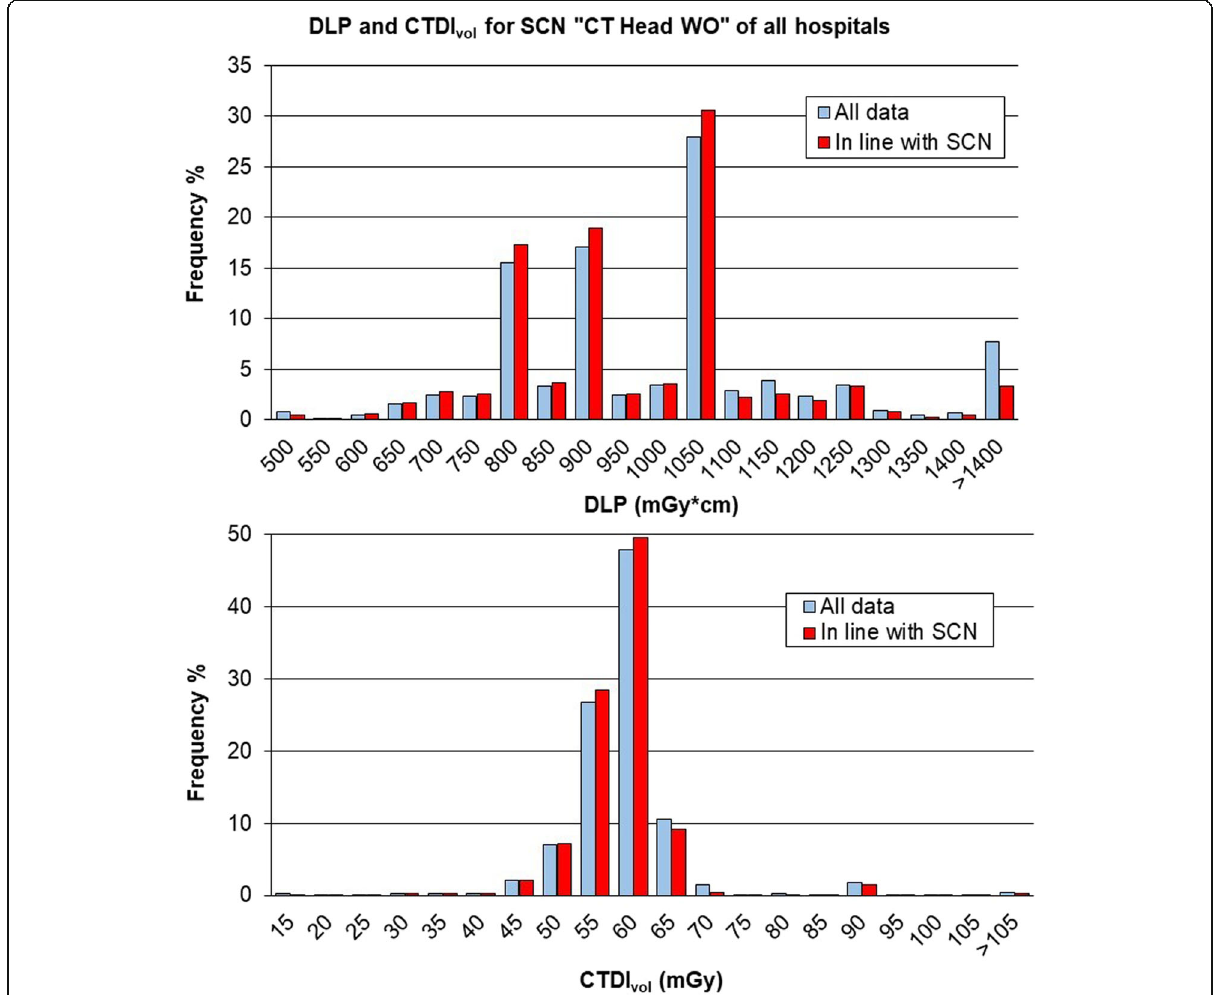
Fig. 7 Comparison between distributions of total dose-length product (DLP) and volumetric computed tomography dose index (CTDI vol ) of the whole data and those in line with the study common name (SCN) “ CT Head WO ” , i.e ., studies with all series belonging to that